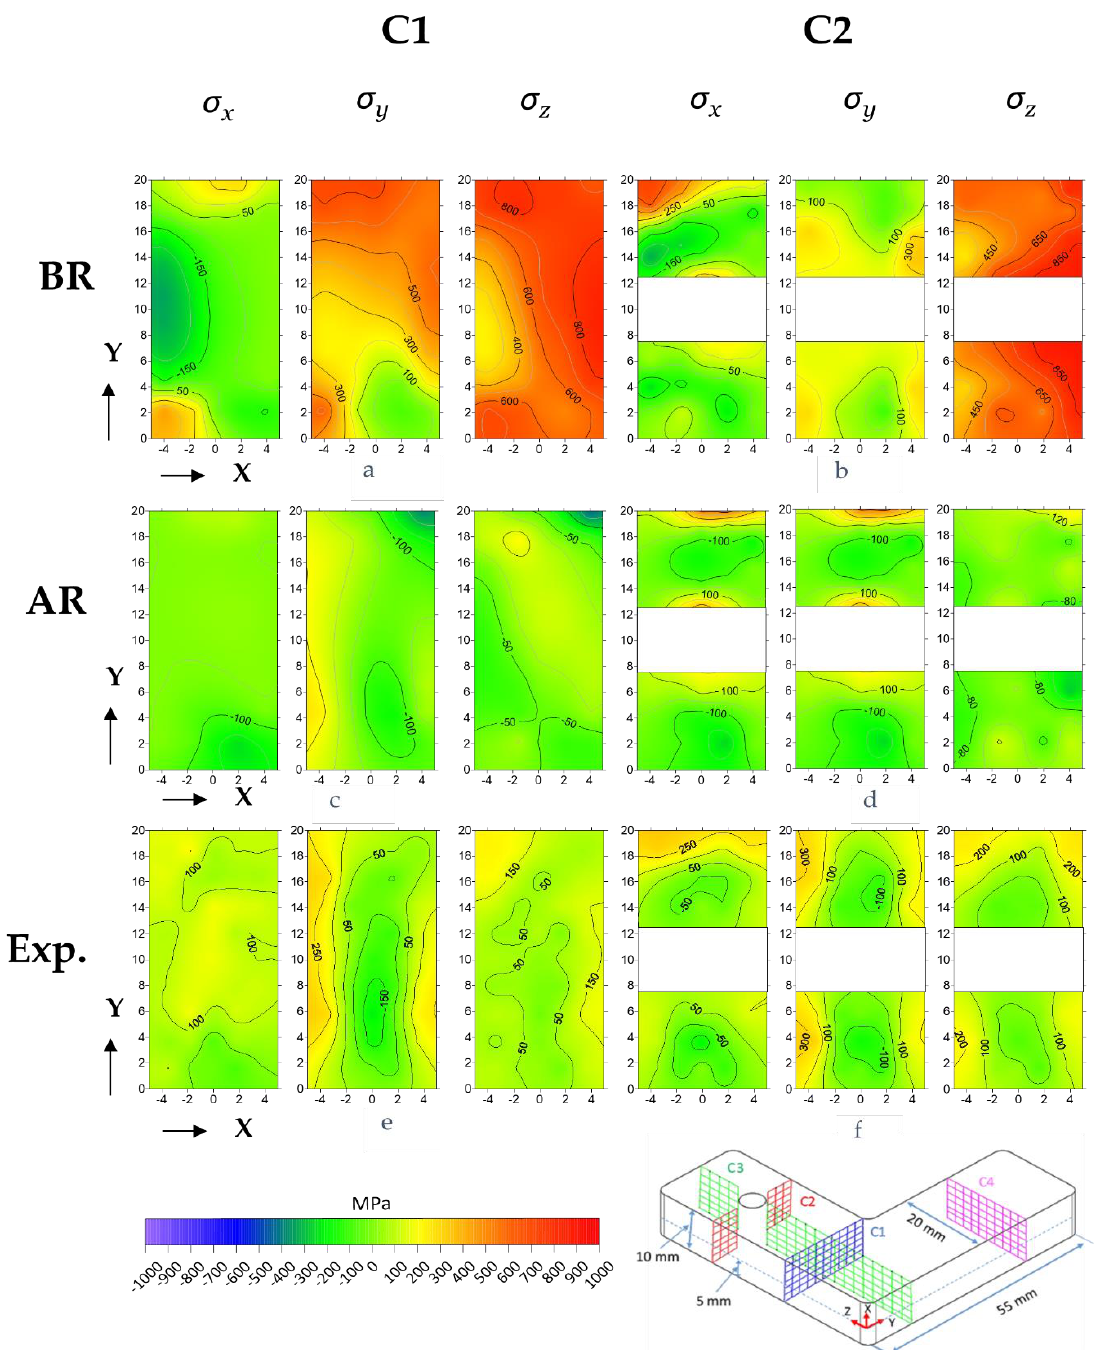
Figure 12. Stress distribution for HB sample at cross-section C1 and C2. ( a , b )-Results from simulation before base plate removal, ( c , d )-Results from simulation after removal of the base plate, ( e , f )-Experimental results reprinted from ref. [30].